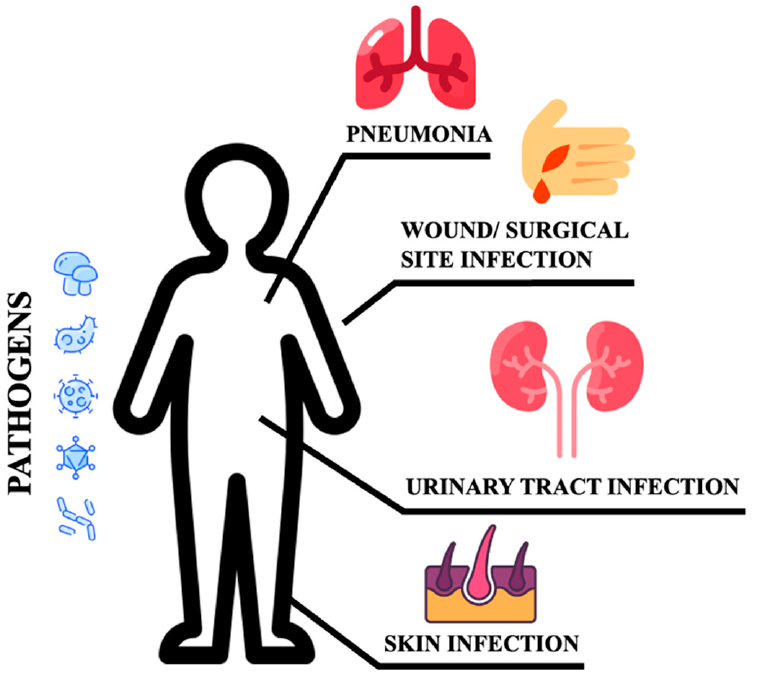
Figure 1. Sites of